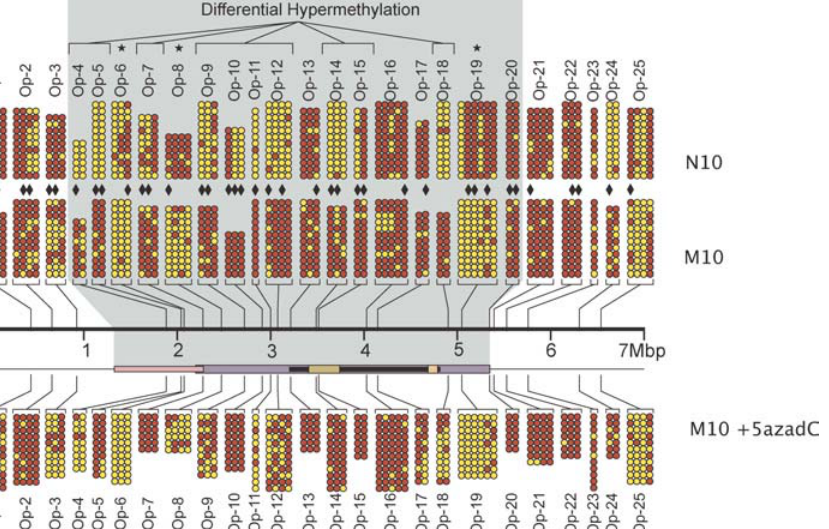
Figure 3. Methylation Analysis of CpG Orphans A total of 75 CpG orphans were selected from 25 sites (Op-1 to Op-25). Red circles denote methylated CpG dinucleotides, and yellow circles denote unmethylated CpG dinucleotides. The positions of Op-1 to Op-25 sites with respect to the previously defined centromeric chromatin domains (shaded area) are indicated (refer to Figure 2E for details). Sites showing differential hypermethylation following neocentromere formation are labeled on top. Sites showing differential hypomethylation are denoted by asterisks. CpG dinucleotides that are putative MeCP2-binding sites are indicated by solid diamonds. Upon treatment with 5-aza-dC, a number of CpG orphans (Op-4, Op-9, Op-11, Op-12, Op-17, and Op-18) demonstrated a significant decrease in DNA methylation. DOI: